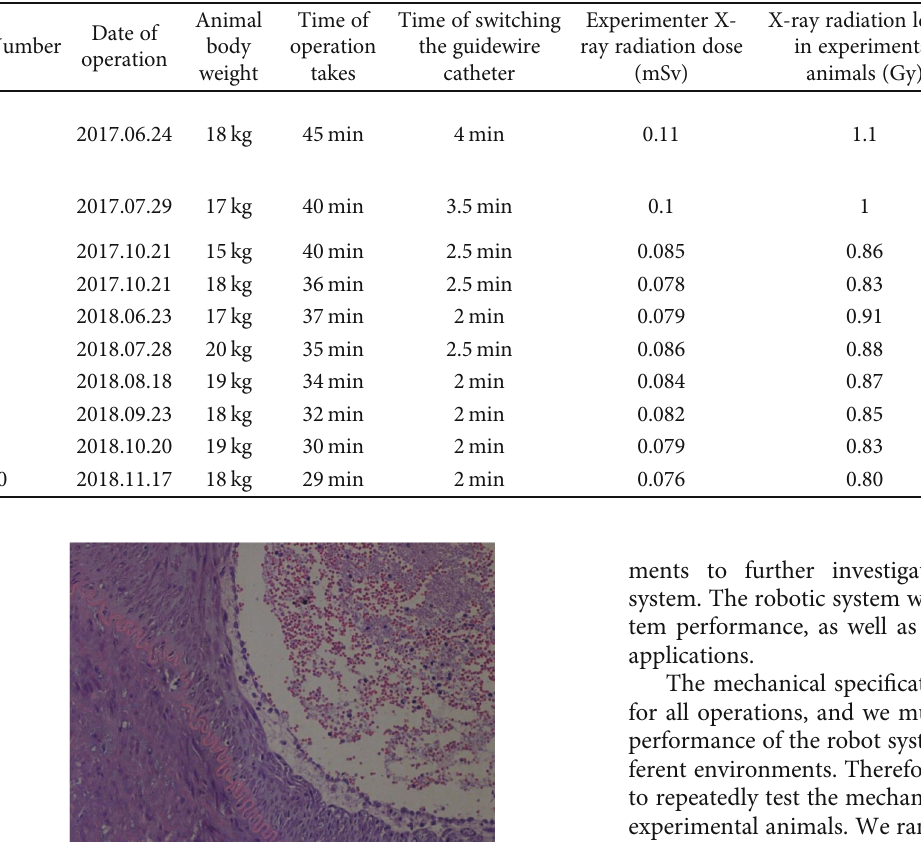
Table 1: Partial experimental data.